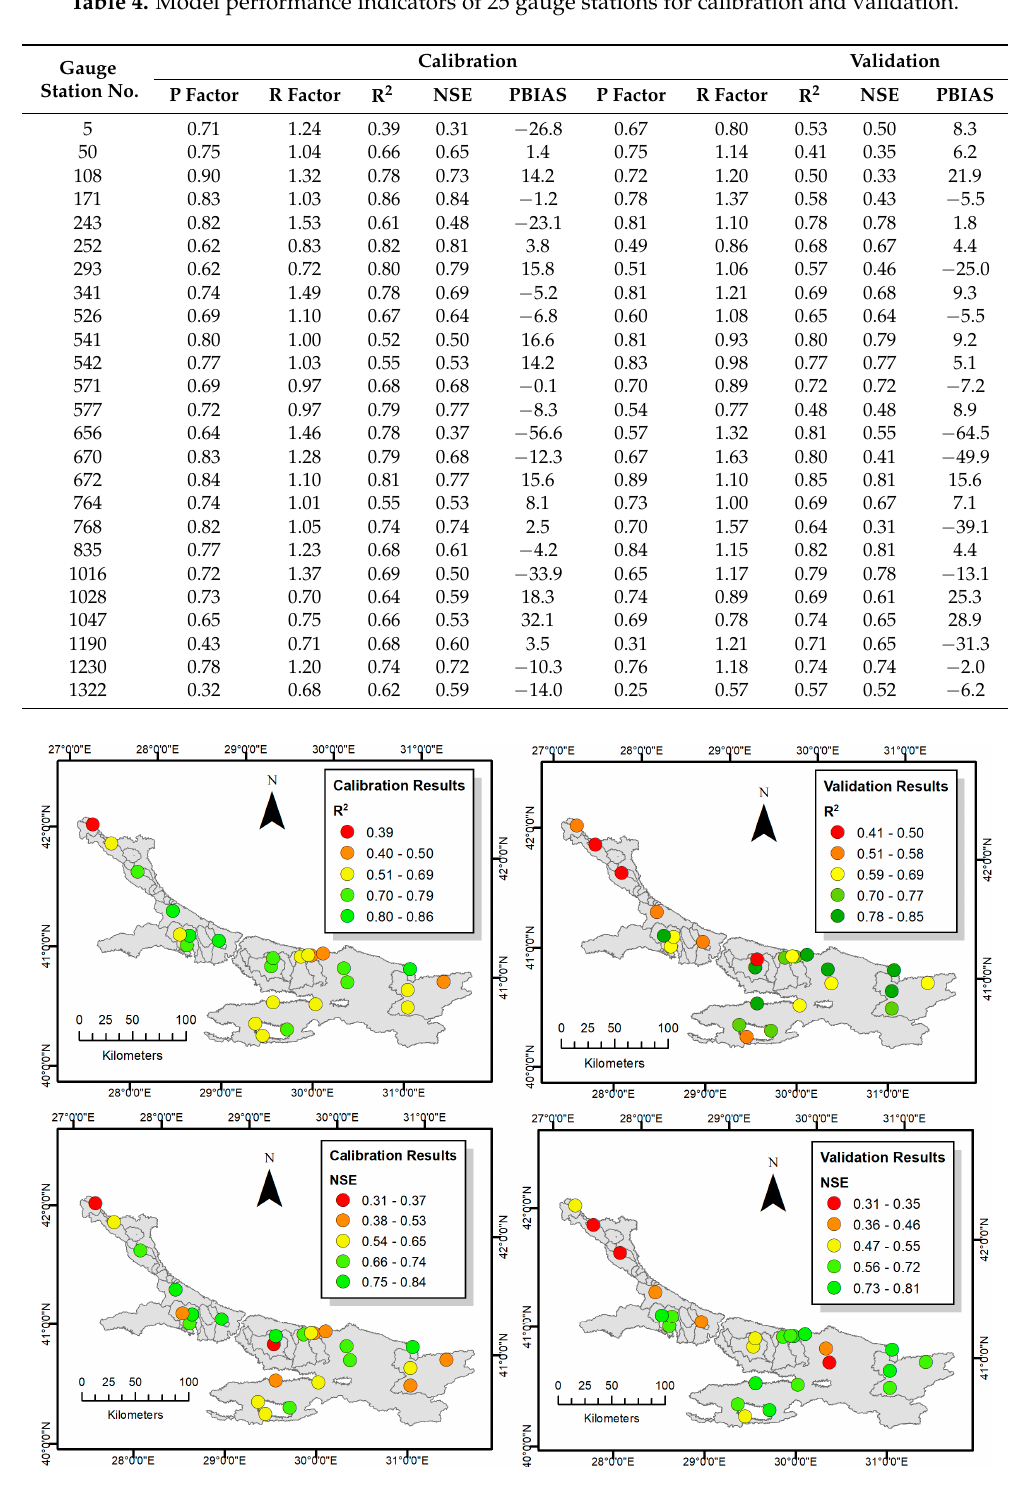
Figure 7. Comparison of simulated and observed discharge data using the coefficient of determination (R 2 ) and Nash–Sucthlife coefficient (NSE) for the calibration and validation period. Average discharge rates of the rivers in the study area varies from 0.2 m 3 s − 1 to 44 m 3 s − 1 (Figure 8). Extreme discharge values of about 150 m 3 s − 1 were captured by our model quite well. For the